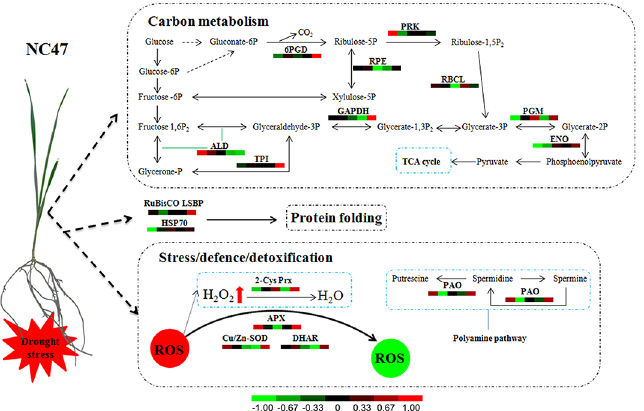
Fig 7. Drought stress-mediated changes in metabolic pathways of NC47 seedling